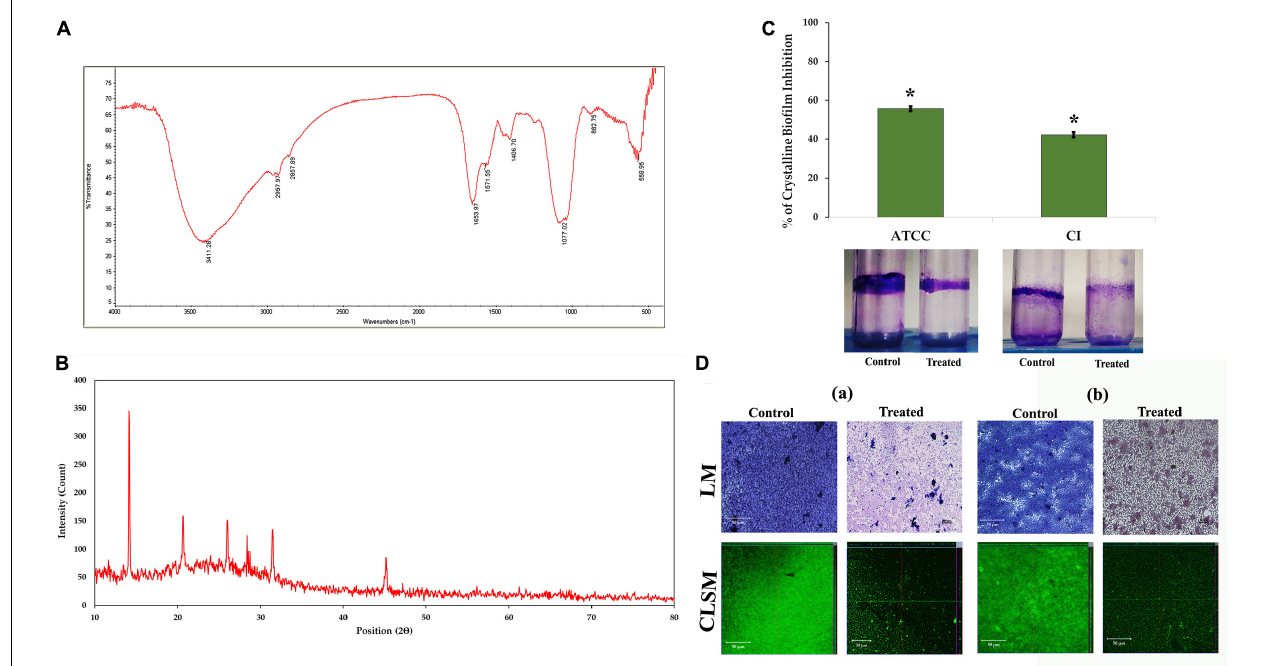
FIGURE 3 | Crystalline biofilm production. (A) FT-IR and (B) XRD analyses of struvite/apatite crystal precipitates. (C) Assessment of HMB (at its MBIC) on crystalline biofilm of Proteus mirabilis . Data represent mean values ( n = 3) ± standard deviation. ∗ indicates significance at P < 0.005. (D) Microscopic (LM and CLSM) analysis of P. mirabilis (a) ATCC and (b) CI crystalline biofilm formation in the presence and absence of HMB at MBIC. FT-IR, Fourier transform infrared; XRD, X-ray diffraction; HMB, 2-hydroxy-4-methoxybenzaldehyde; MBIC, minimum biofilm inhibitory concentration; LM, light microscopy; CLSM, confocal laser scanning microscopy; CI, clinical